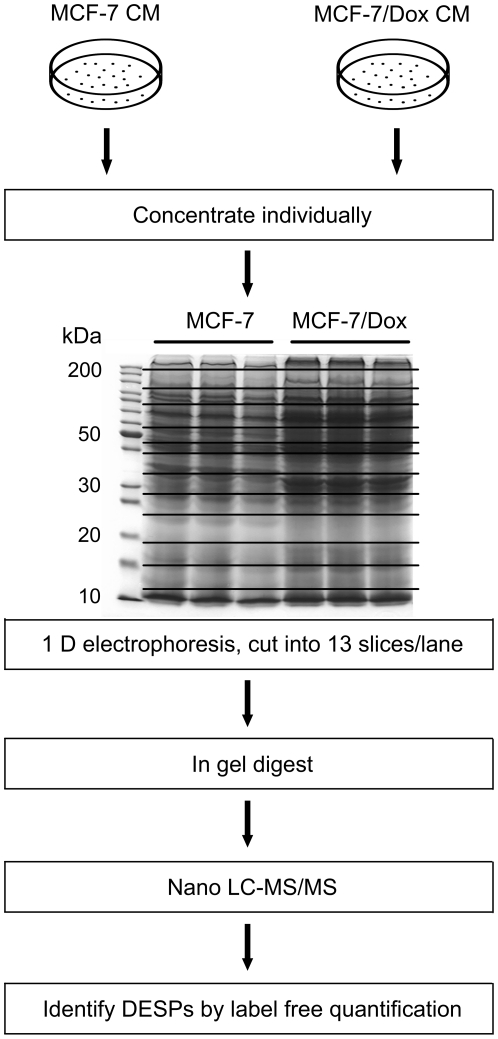
Workflow for the comparative secretome analysis of MCF-7 and MCF-7/Dox.Illustration of the label-free approach to identify the differential proteins in the CM of MCF-7 and MCF-7/Dox cell lines.